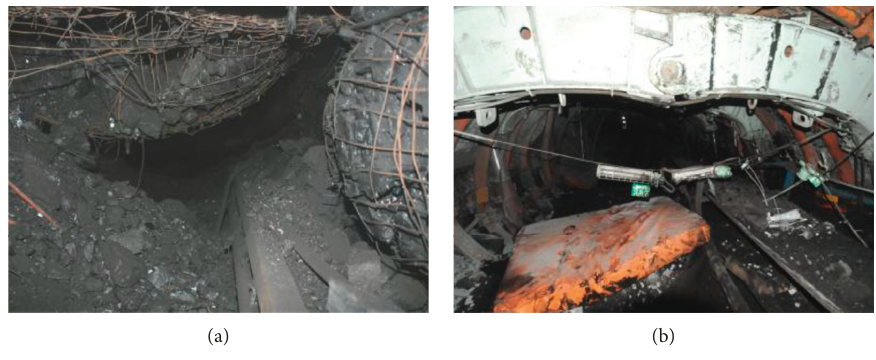
Figure 1: Scene picture after rock burst disaster